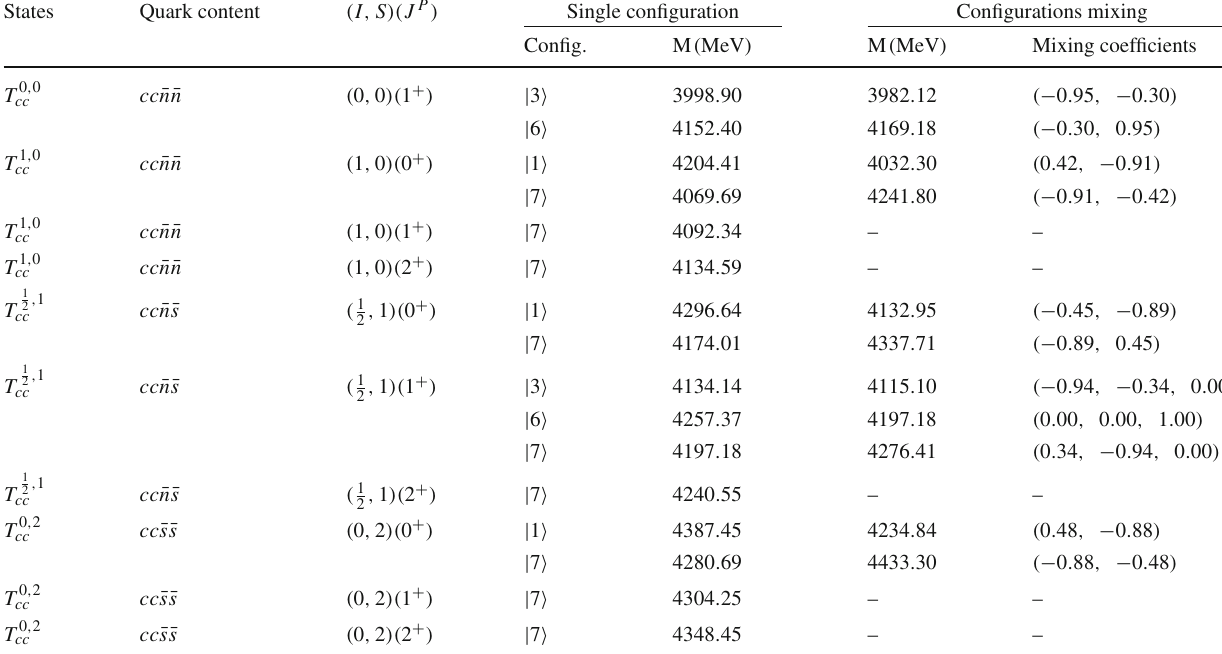
Table 13 The model results of ground S -wave double-charm tetraquark states. States